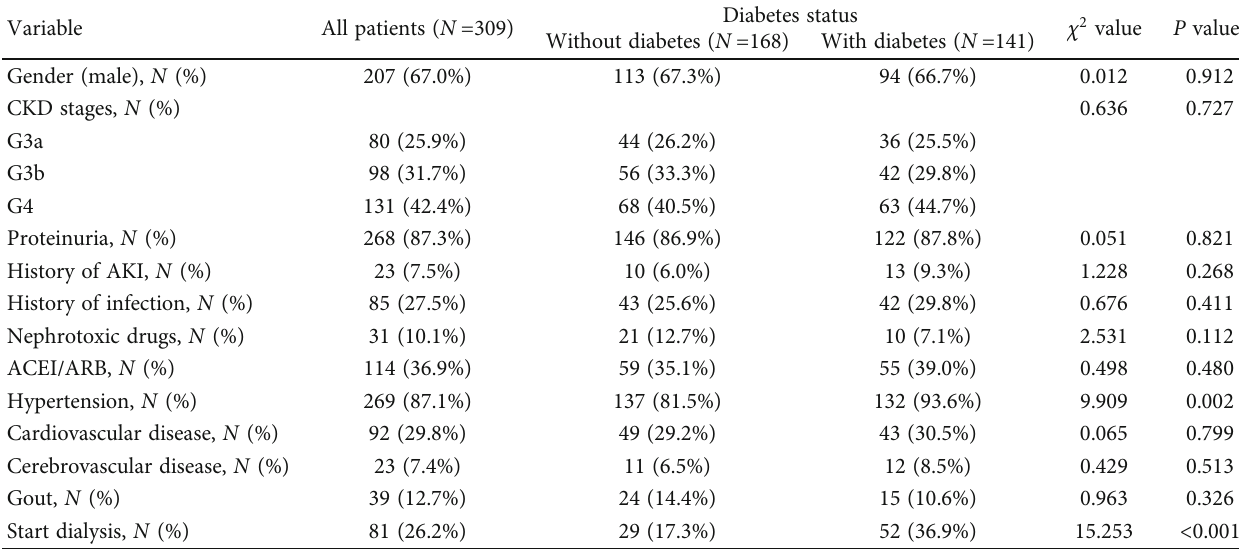
Table 2: Baseline clinical characteristics of all patients and diabetic